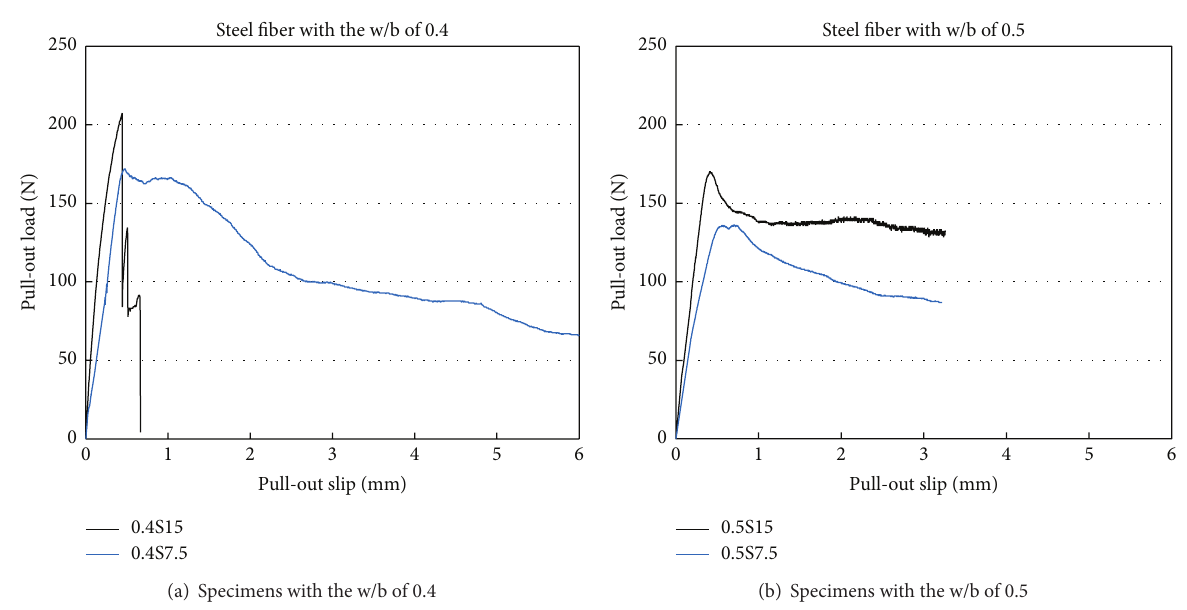
Steel fiber with the w/b of 0.4